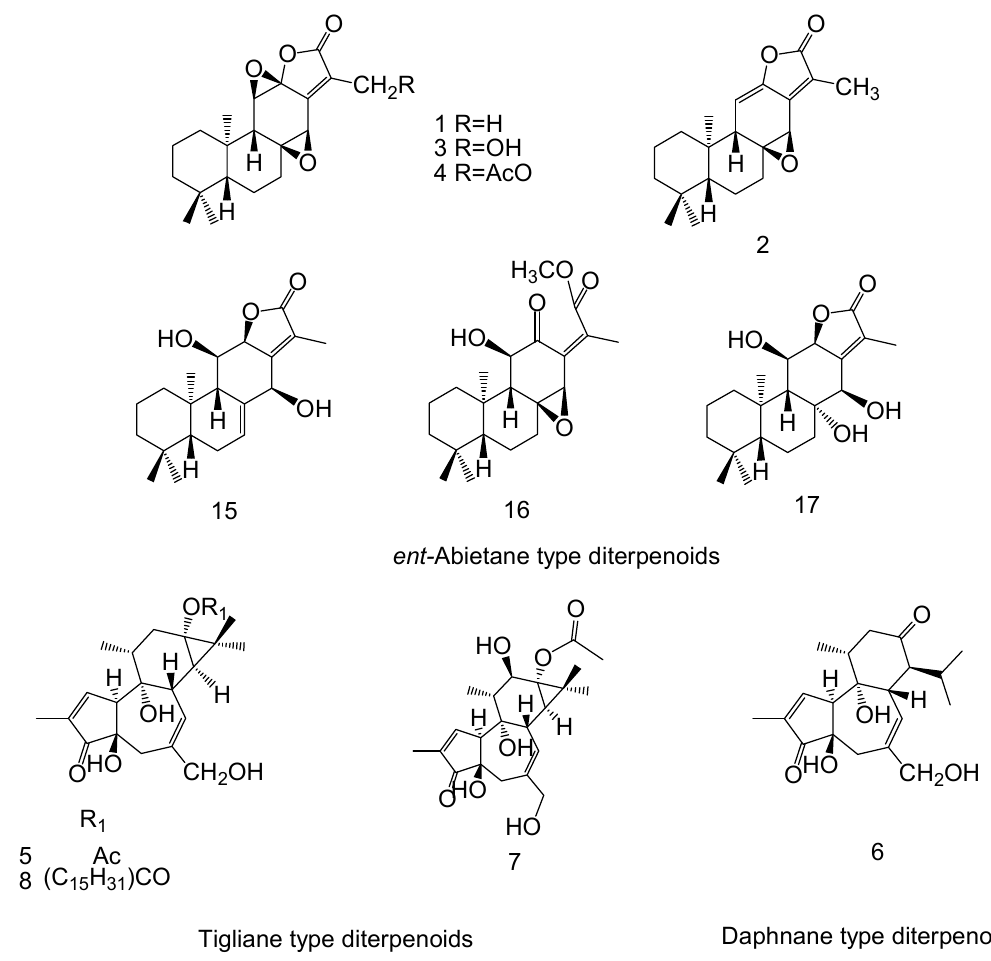
Figure 1. The chemical structures of ent -abietane-, tigliane- and daphnane-type diterpenoids derived from E. fischeriana.